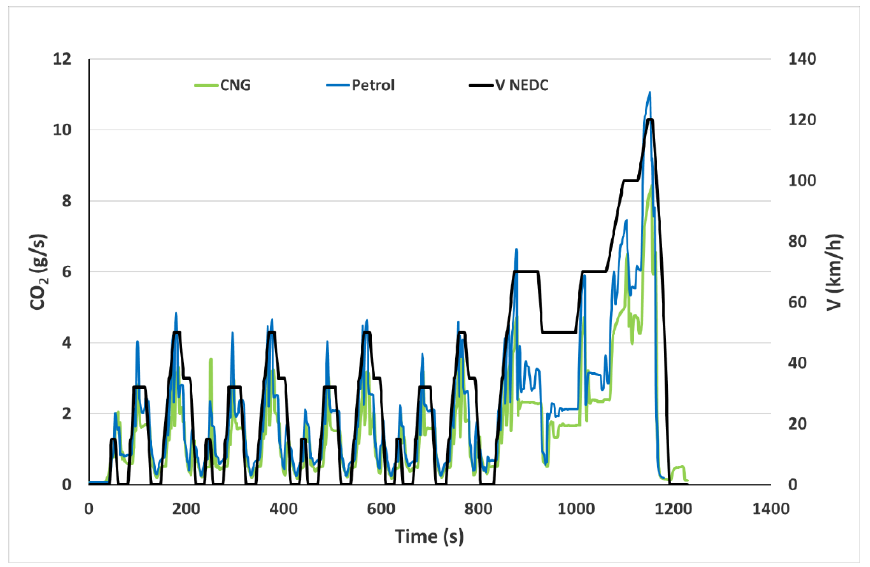
Figure 5. Comparison of CO 2 emission between petrol and CNG propulsion in NEDC test.